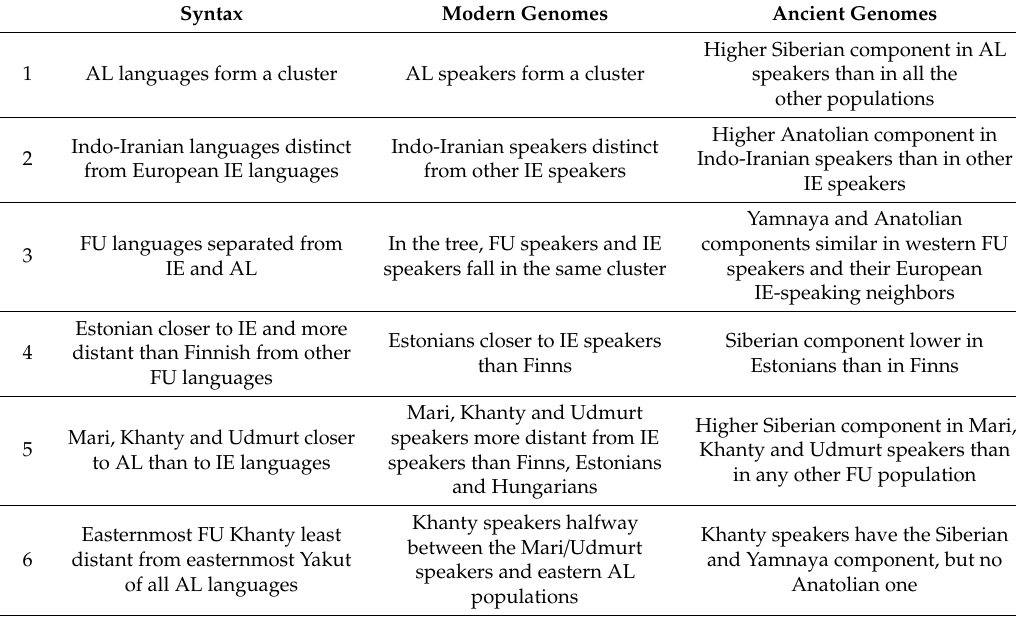
Table 1. Synopsis of the main results of this